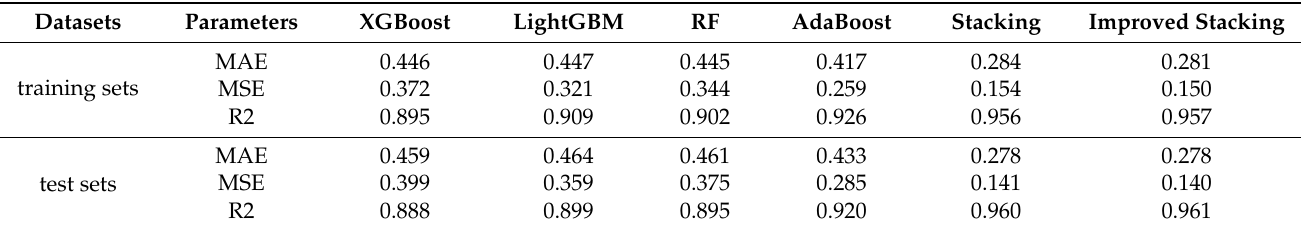
Table 4. Model evaluations of different models on training and test